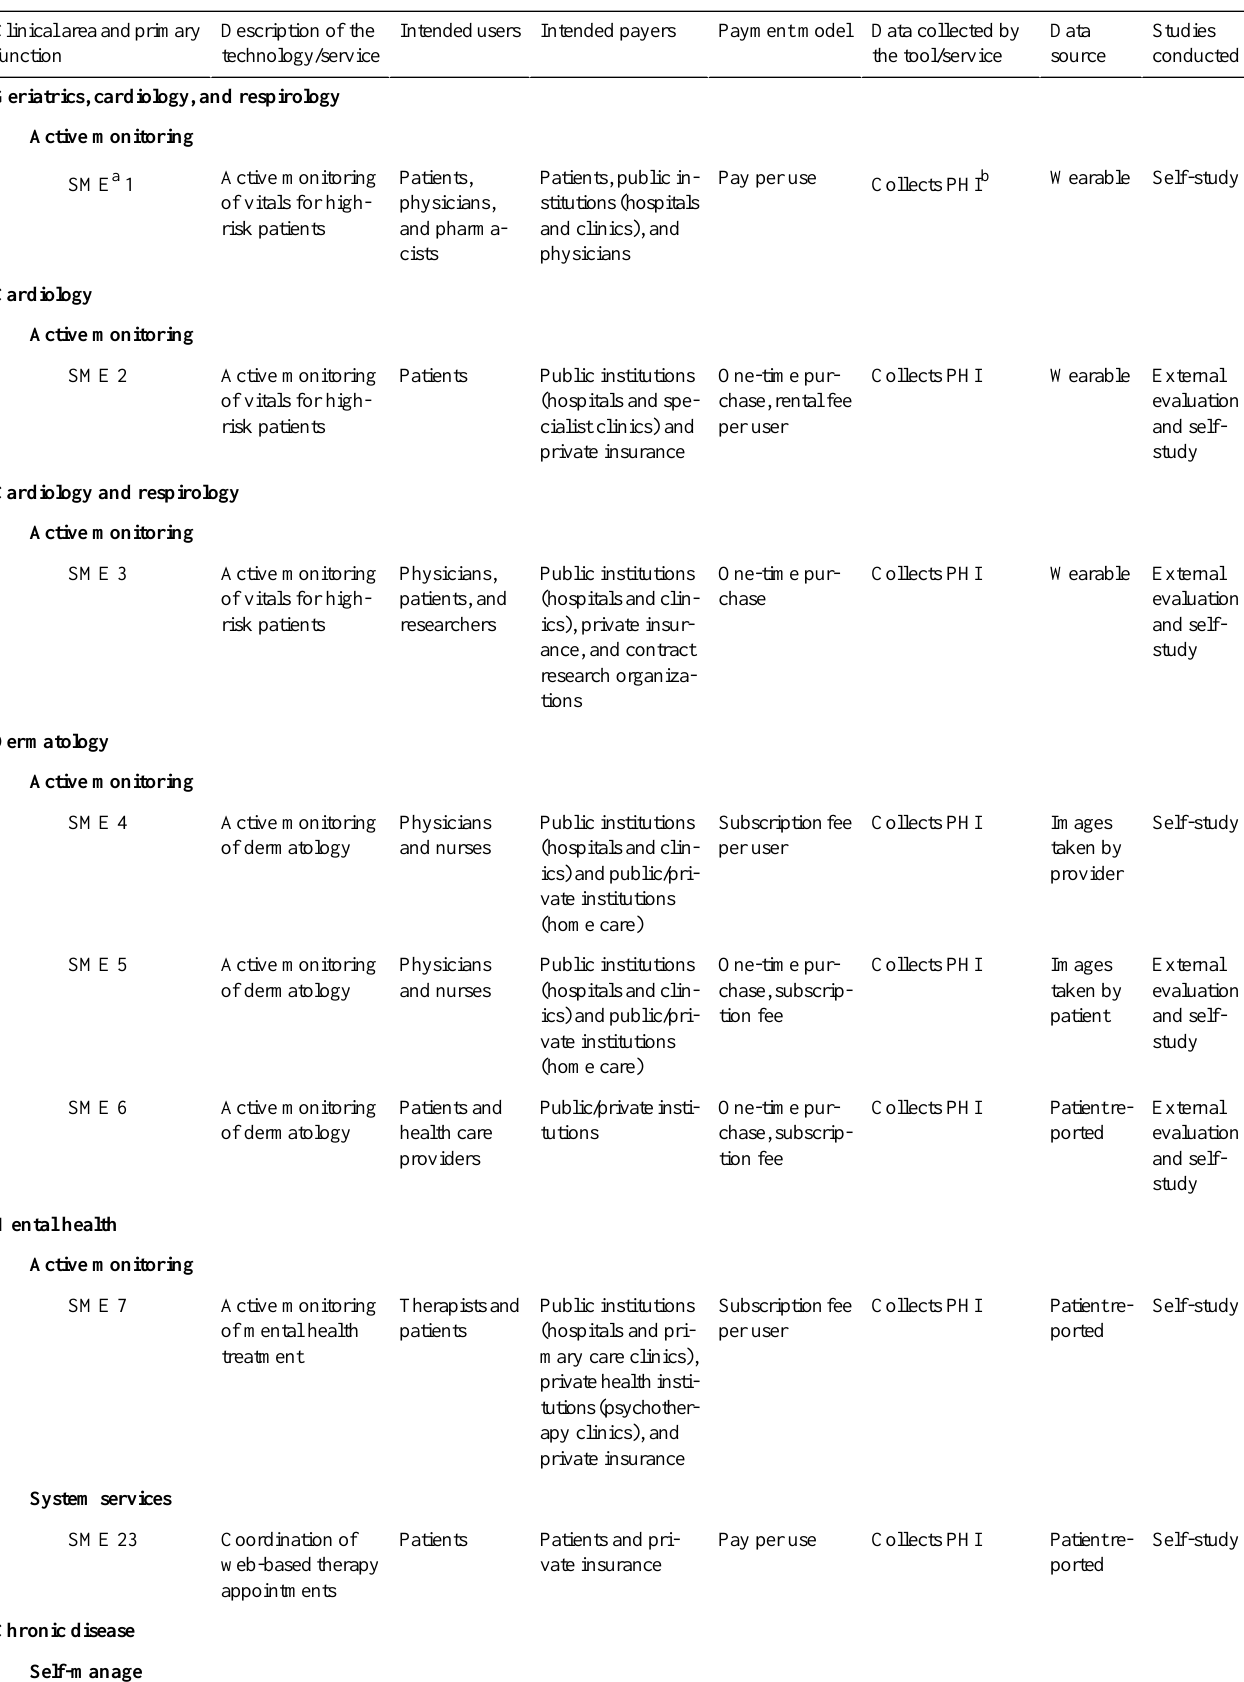
Table 2. Characteristics of small- and medium-sized enterprises’ clinical model, business model, and their digital health tools as extracted from the onboarding forms completed by the small- and medium-sized enterprises, sorted by Clinical